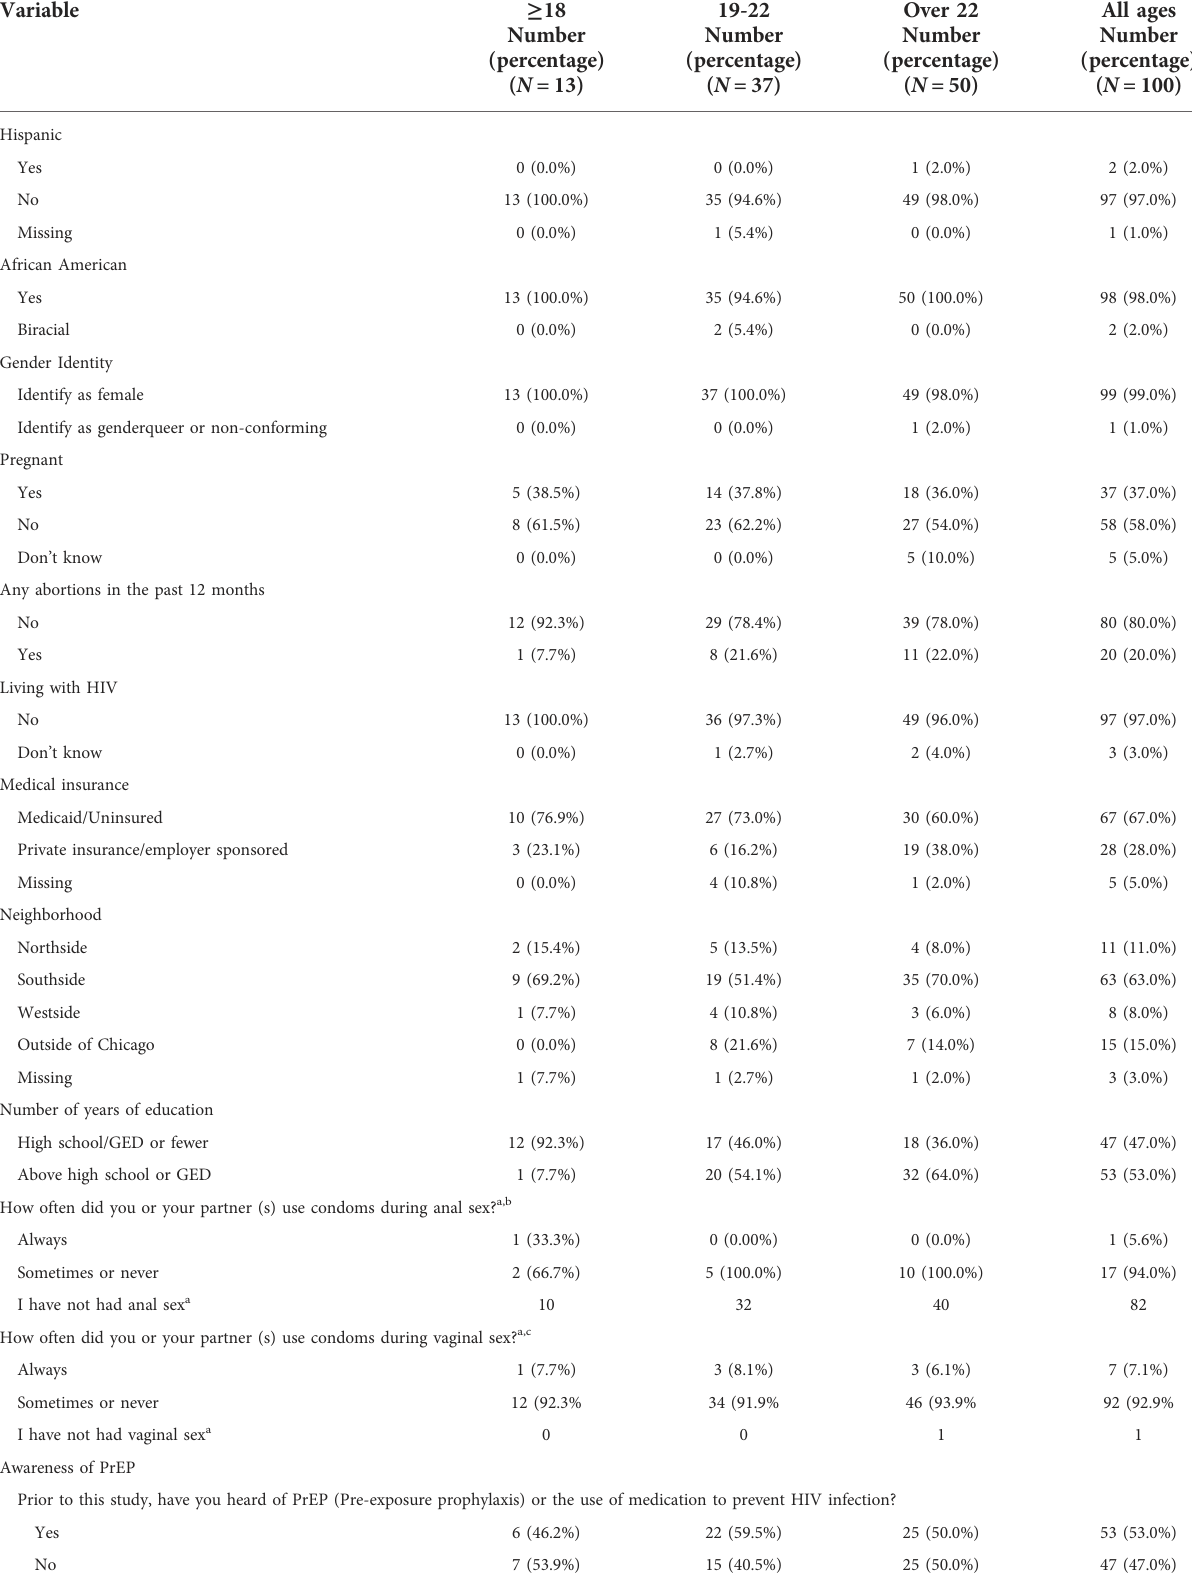
TABLE 1 Demographics and survey responses for study participants, separated by age